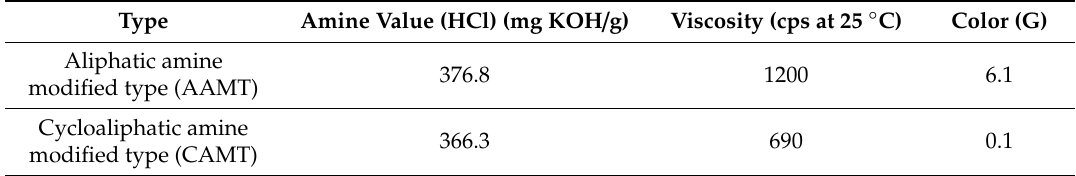
Table 2. Properties of hardeners.